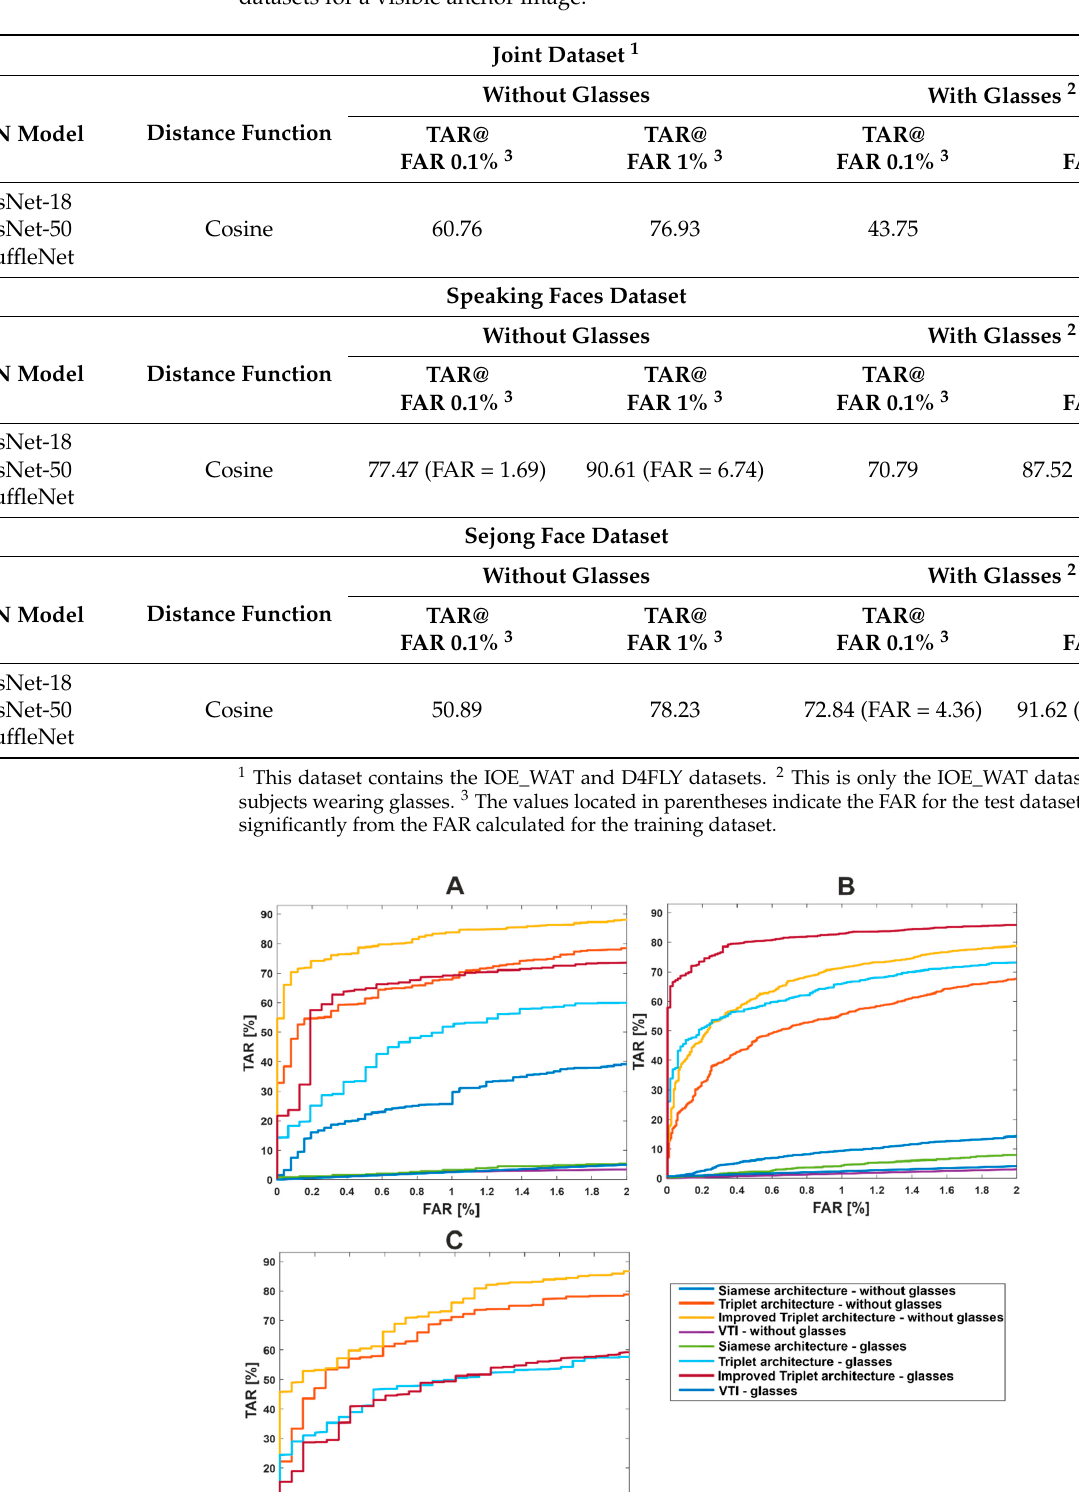
Table 7. Performance of triple triplet algorithms for the IOE_WAT, Speaking Faces, and Sejong Face datasets for a visible anchor image.